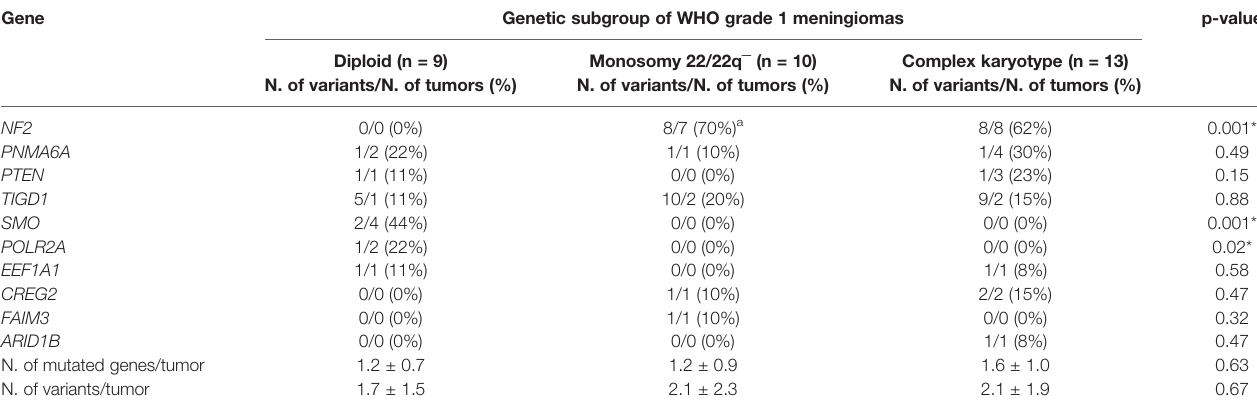
TABLE 2 | Frequency of non-synonymous genetic variants in different cytogenetic subtypes of WHO grade 1 meningiomas as de fi ned by their chromosome copy number pro fi le. Gene Genetic subgroup of WHO grade 1 meningiomas